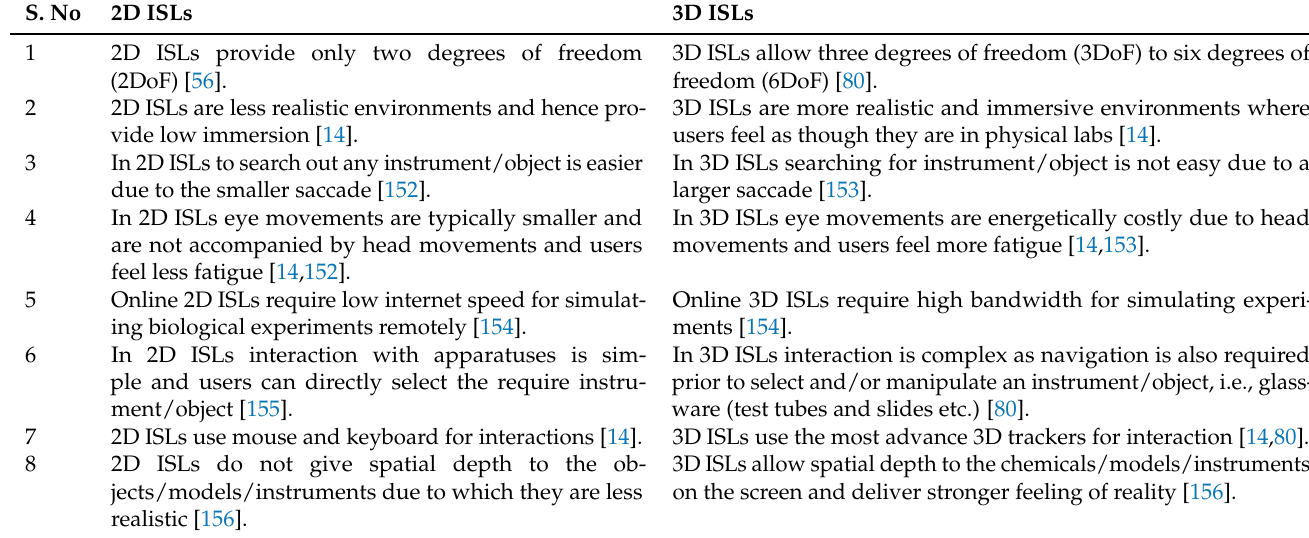
Table 7. Comparison between 2D and 3D interactive